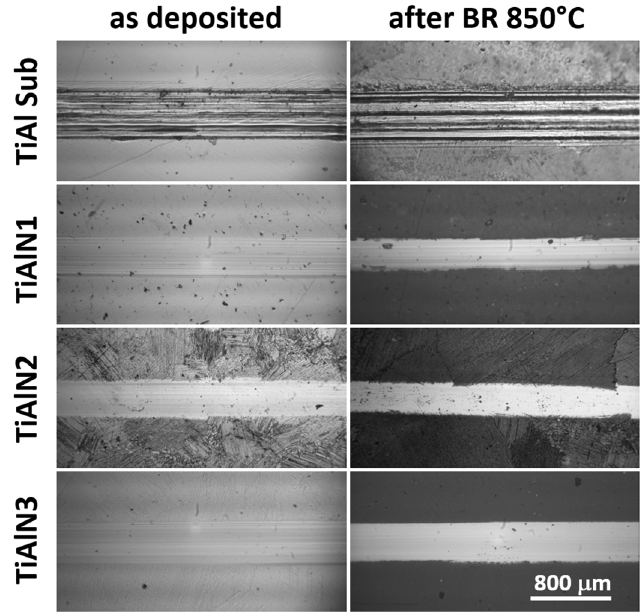
Figure 9. Comparison of wear track optical microscopy images: on the left as deposited samples are shown, on the right samples after 40 cycles up to 850 °C thermal treatment are presented.